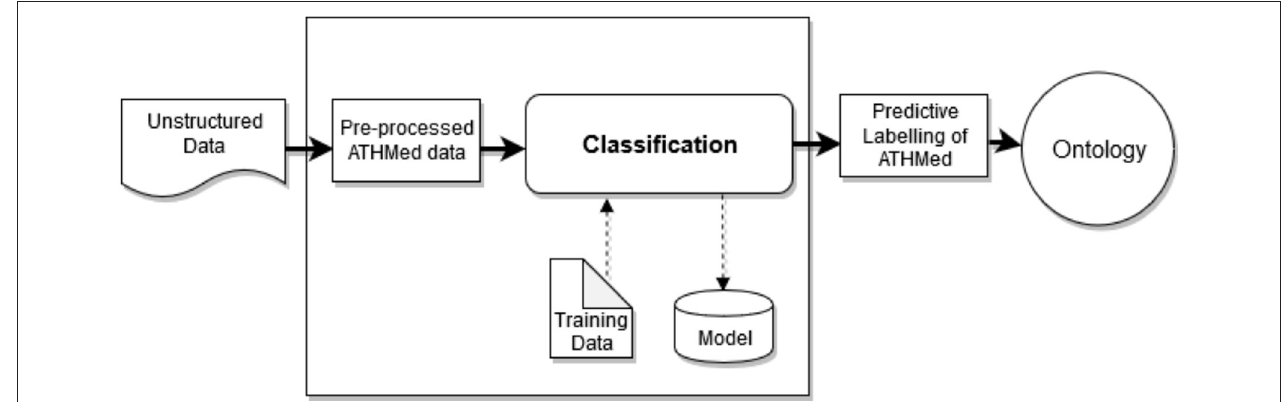
FIGURE 4 | ATHMed classification process.